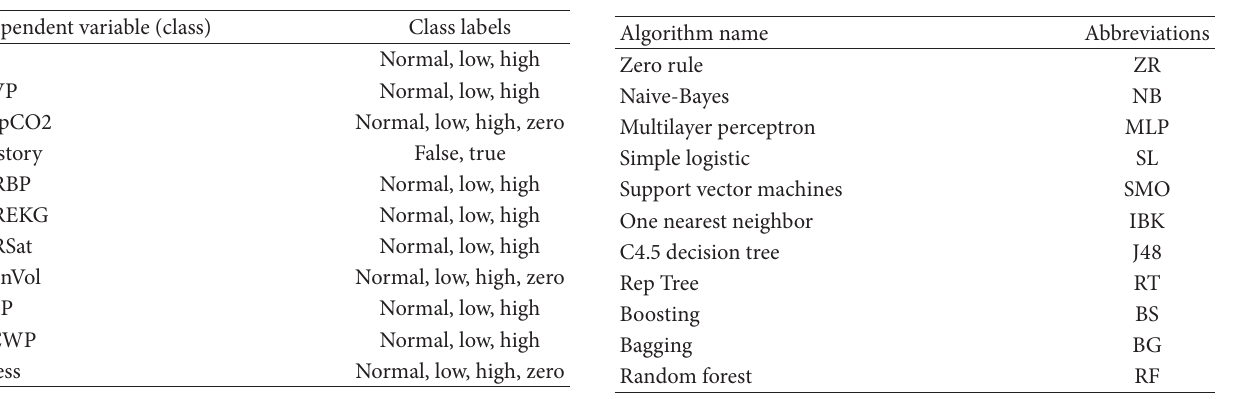
Table 2: The class labels for 11 classification datasets. Table 3: Used classification algorithms and